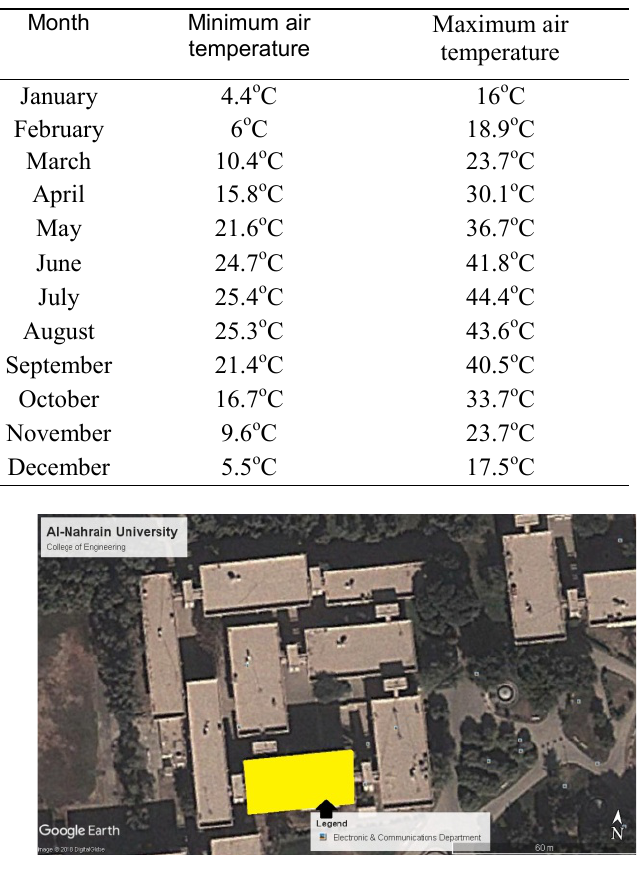
Figure 2 .Department building and the suggested place for the PV system.